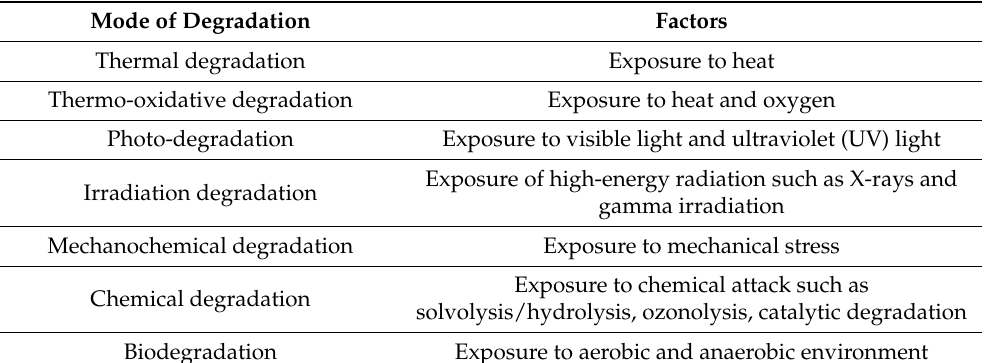
Table 2. Degradation modes of polymeric matrix/coating. Reprinted with permission from Ref. [48]. Copyright 2016, Elsevier.